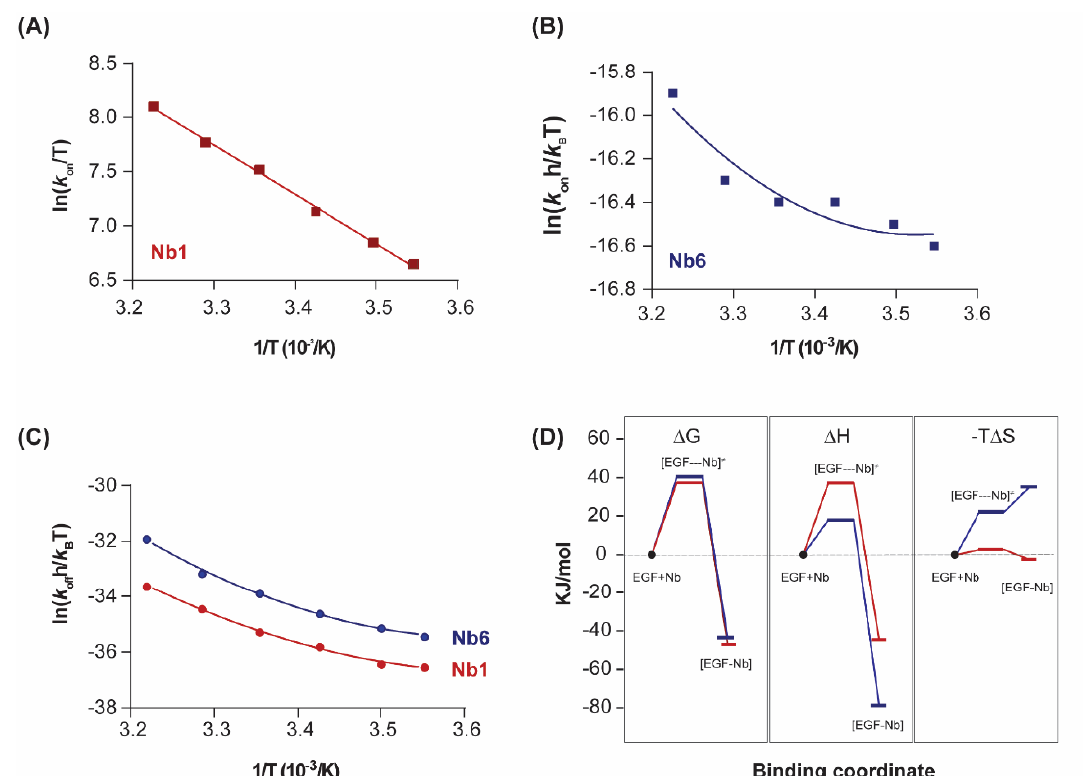
Figure 3. Transition state thermodynamics analysis. ( A, B ) Eyring plots representing the variation of the association constant ( k on ) with the inverse of temperature for Nb1 and Nb6. Linear fitting of the experimental data points to Equation (4) (ΔC ≠ p = 0) was performed in ( A ), while non-linear fitting was performed in ( B ). ( C ) Eyring plots for the dissociationn step of Nb1 and Nb6. Data were fitted to a second-order polynomial from which the transition state thermodynamic parameters were derived according to Equation (4). ( D ) Binding profile of Nb1 and Nb6 illustrating the transitions in ΔG, ΔH, ΔS at 25 °C. [EGF–Nb] ≠ represents the transition state.